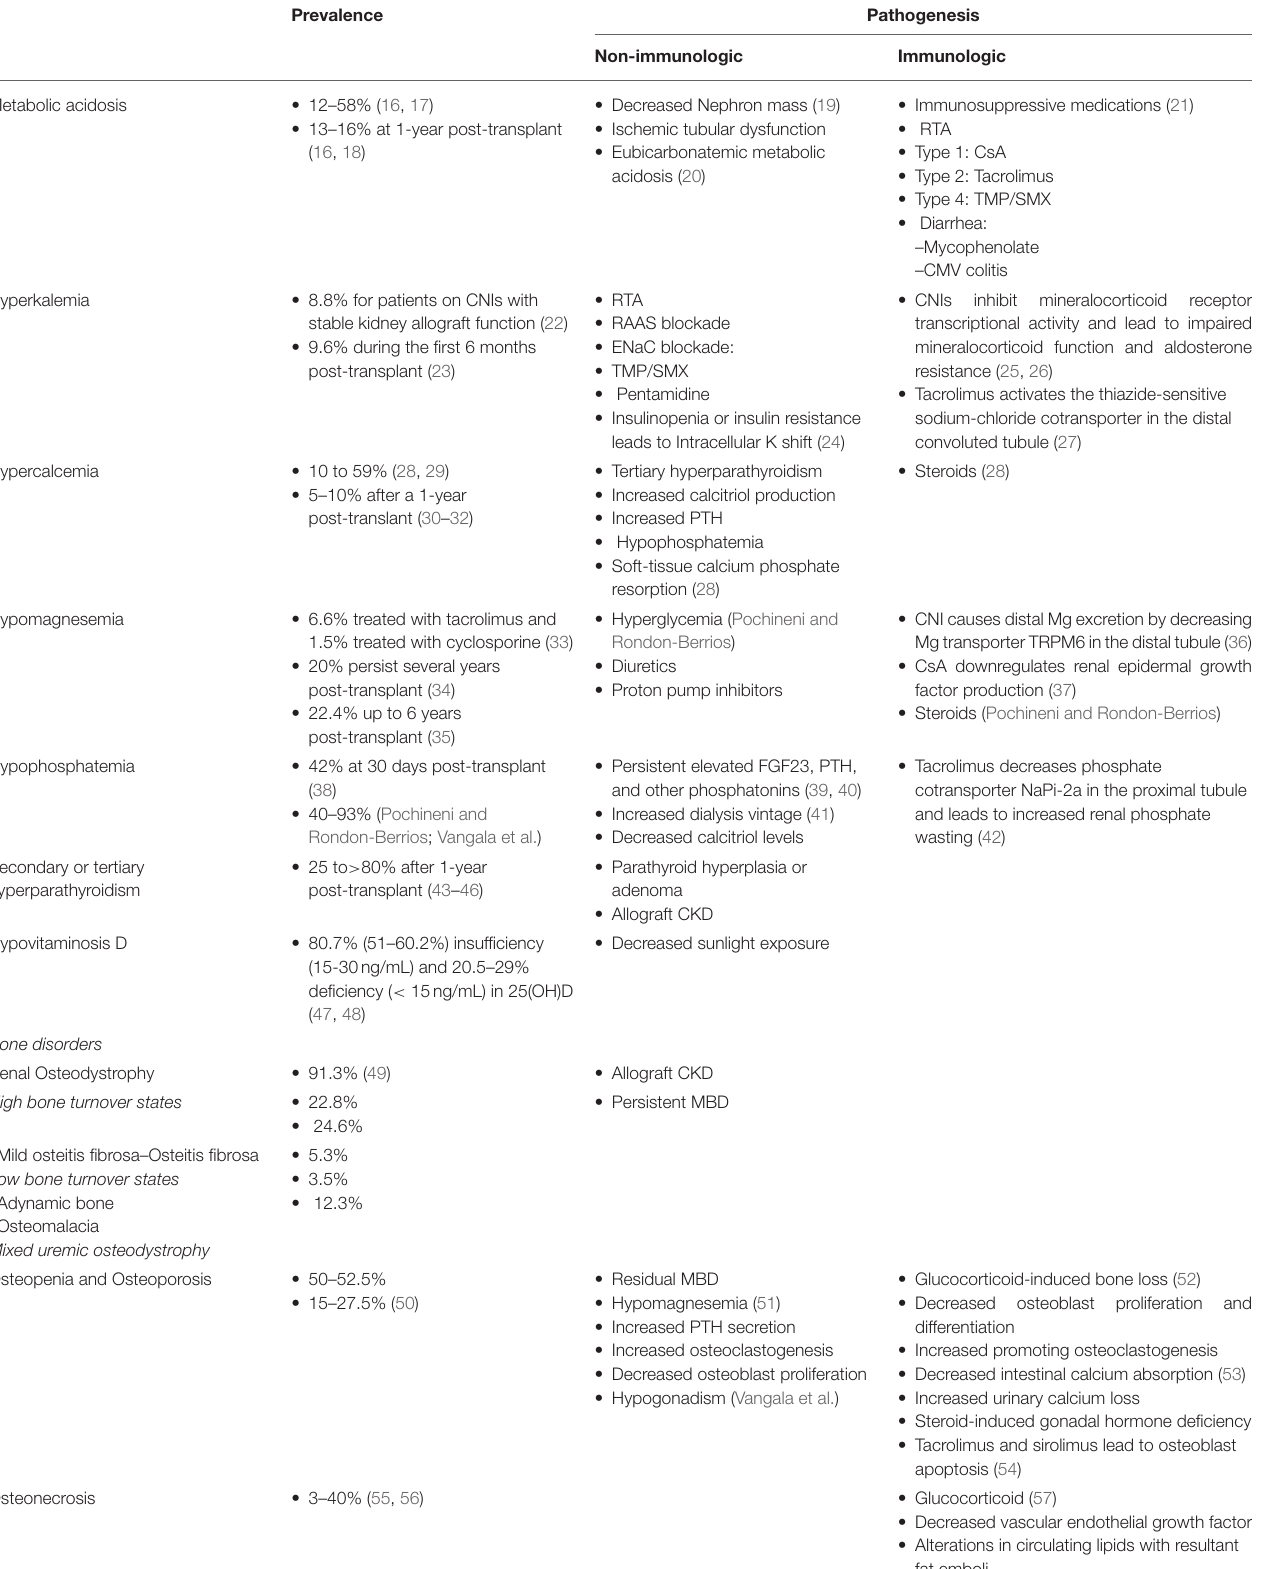
TABLE 1 | Prevalence and pathogenesis of metabolic changes after kidney